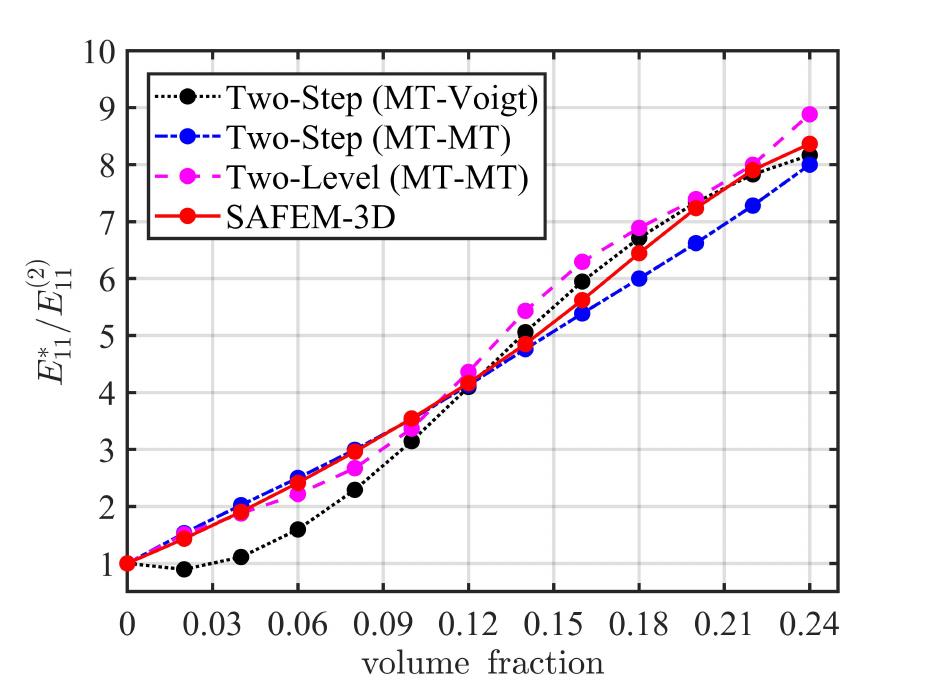
( 2 ) ) as a function of the inclusion’s / E 11 11